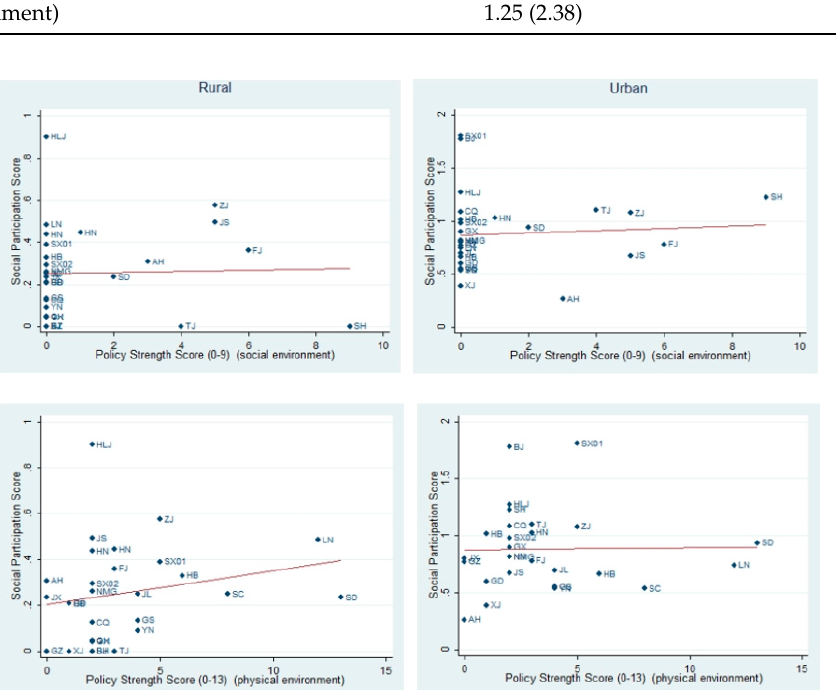
Figure 2. Bivariate Associations between Social Participation Score of older adults and Policy Strength Score in Provinces. Source: CHARLES 2011, Data coding from plan documents by authors.